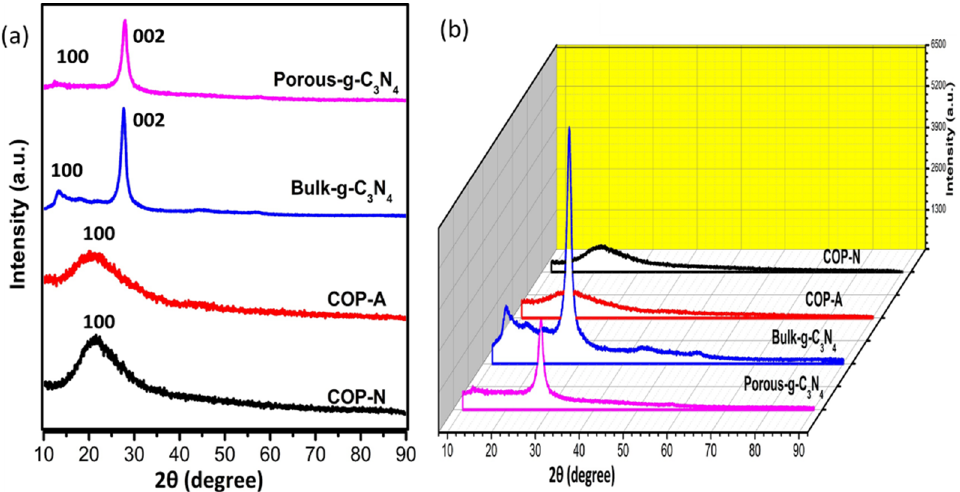
Figure 4. XRD spectra ( a ) 2D and ( b )3D view of B-GCN, P-GCN , COP-N and COP-A. The yelloe are indicates the intensity